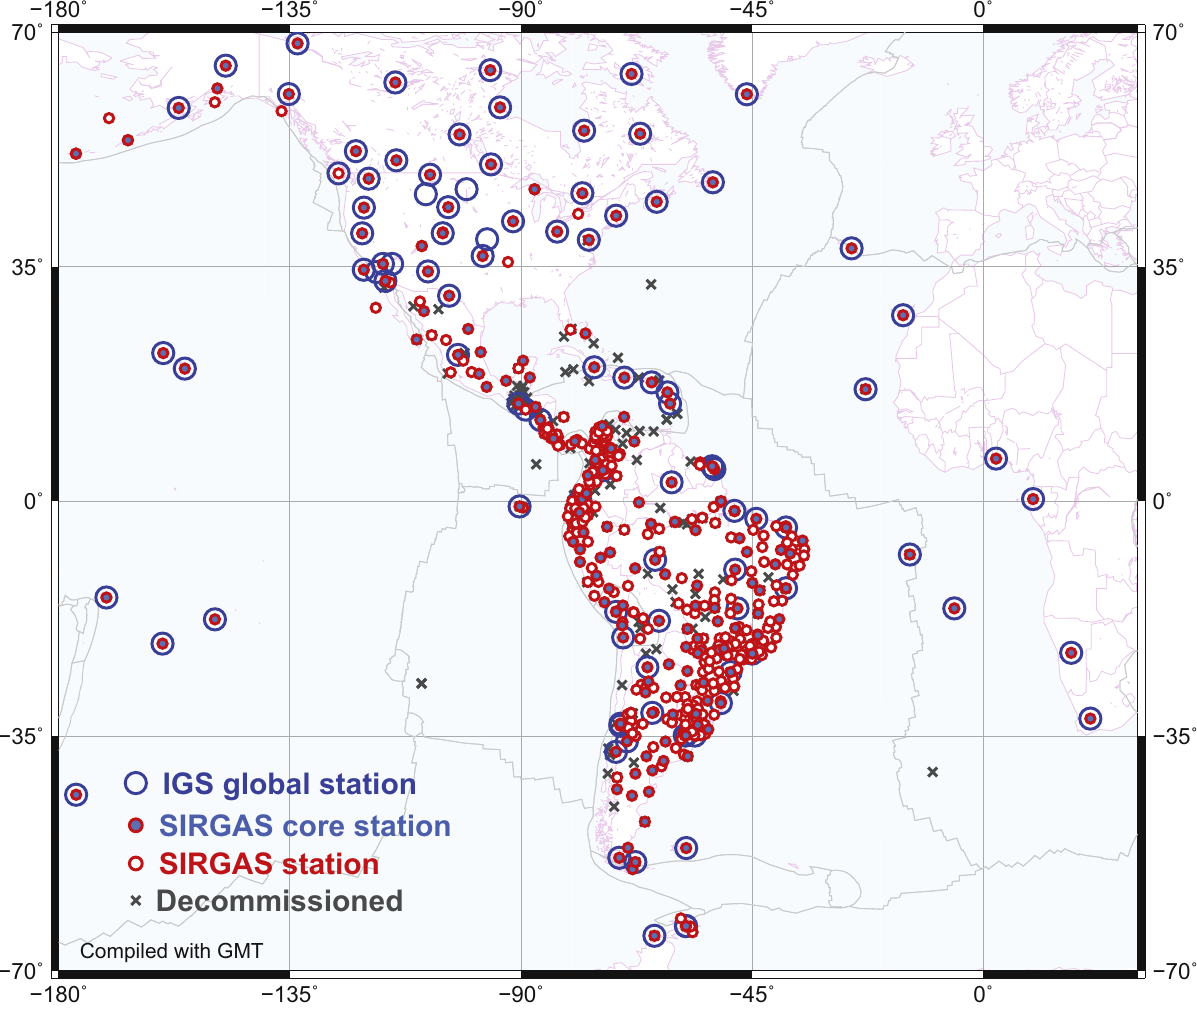
Figure 1: SIRGAS reference network ( as of April 2022 )